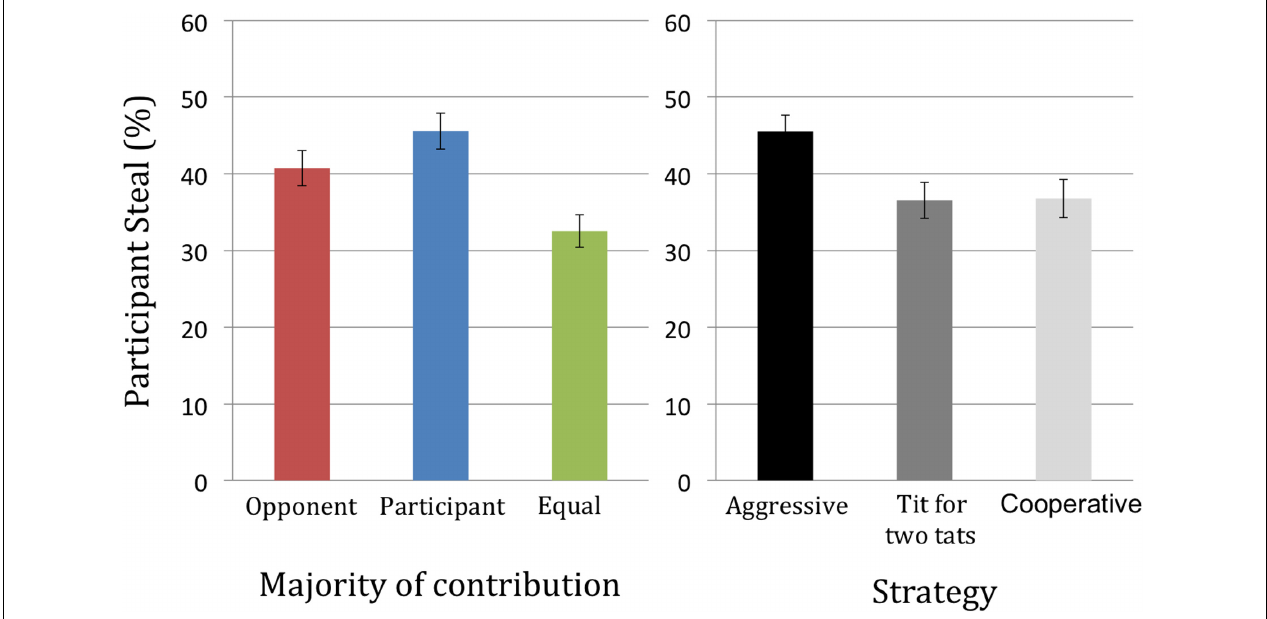
FIGURE 5 | Participant defect percentage for each level of contribution and